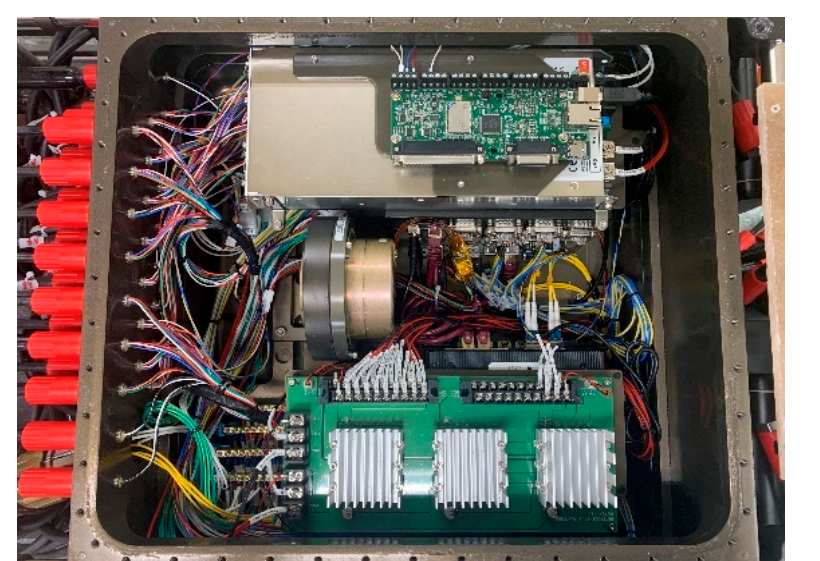
Figure 5. TUP pressure-resistant box.